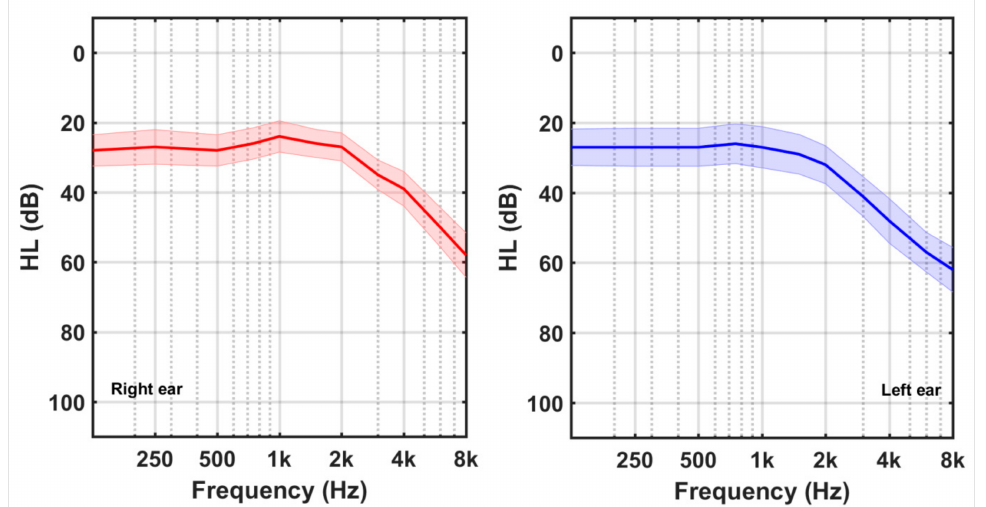
Figure 3. Average HL curves of the hearing impaired (HI)